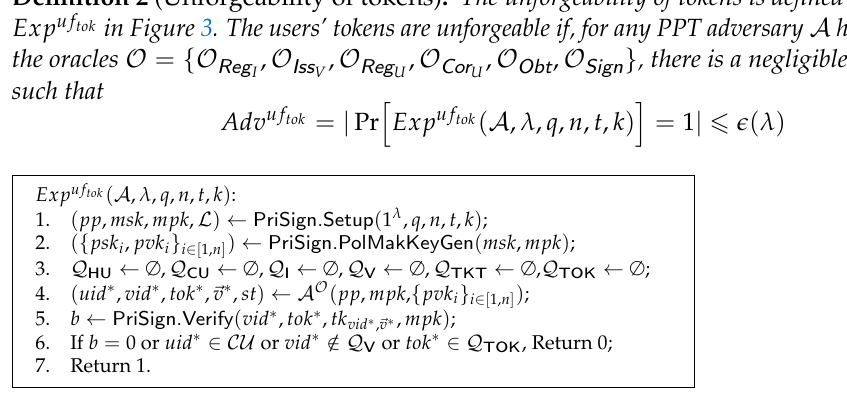
Figure 3. Unforgeability of tokens.